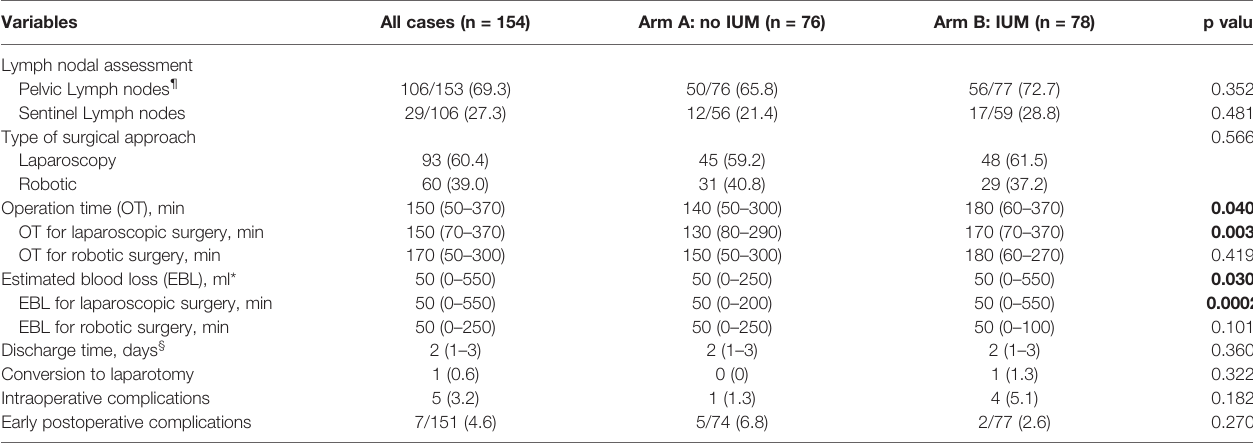
TABLE 2 | Perioperative